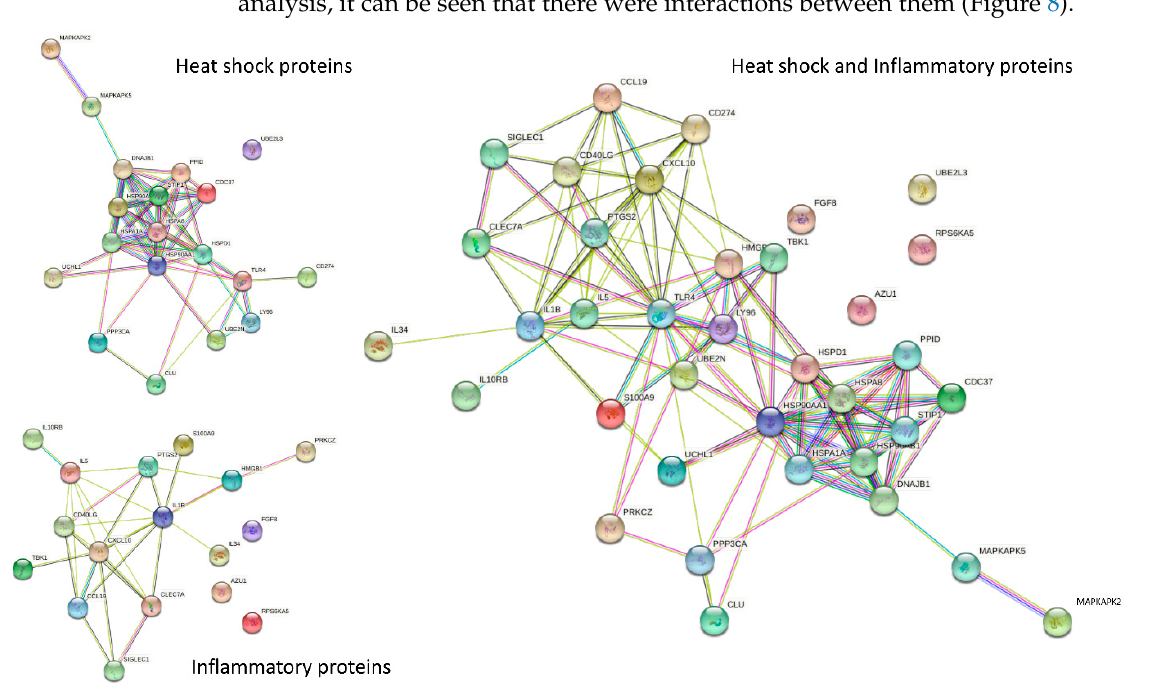
Figure 8. STRING interaction network showing the interactions of heat shock-related proteins. STRING 11.0 (Search Tool for the Retrieval of Interacting Genes) was used to visualize the recognized and predicted protein–protein interactions for the heat shock and inflammatory proteins reported here (https://string-db.org/ (accessed on 1 September 2021)). Network nodes represent proteins, and the lines reflect physical and/or functional interactions of proteins. Empty nodes represent the proteins of unknown three-dimensional structure, and filled nodes represent the proteins with some three-dimensional structure, either known or predicted. Different colored lines between the proteins represent the various types of interaction evidence in STRING (databases, experiments, neighborhood, gene fusion, co-occurrence, text mining, co-expression, and homology): here, known interactions are shown in light blue (from curated databases) and pink (experimentally determined); predicted interactions are shown in dark blue (gene co-occurrence); relationships gleaned from text mining (lime green), co-expression (black), and protein homology (mauve) are also shown. The heat shock proteins and the inflammatory proteins are shown separately ( left ) and combined ( right ).